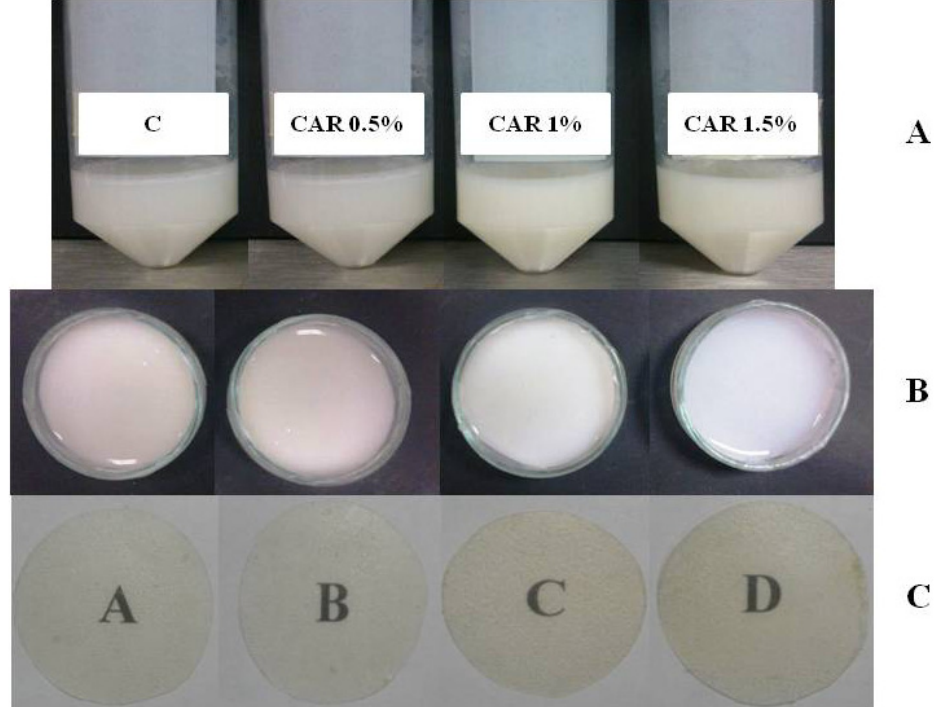
Figure 1. Photographs of the processes preparation of the film: ( A ) emulsions; ( B ) film forming solution in petri dishes; ( C ) film